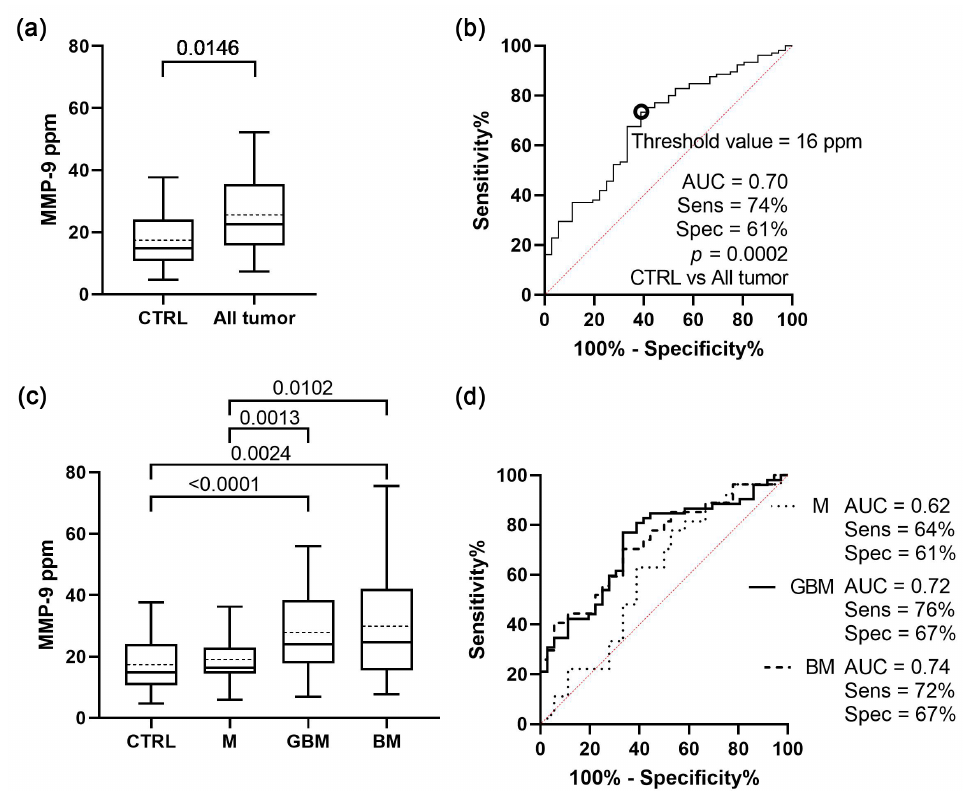
Figure 3. Comparative analyses of MMP-9 level of serum sEVs on the four main groups. ( a ) Graph shows the MMP-9 level of the control group comparing all the tumour patients (median with interquartile range, mean with dotted line, error bars range from the 5th–95th percentiles; nCTRL = 36, nAll tumour = 105). ( b ) ROC curves for exploring the differences between the MMP-9 level of the control group and all the tumour patients (nCTRL = 36, nAll tumour = 109). ( c ) Diagram shows the MMP-9 level of serum sEVs among the four patient groups (nCTRL = 36, nM = 27, nGBM = 52, nBM = 27). ( d ) ROC curves for comparing the three tumour groups to controls (nCTRL = 36, nM = 27, nGBM = 52, nBM = 27).